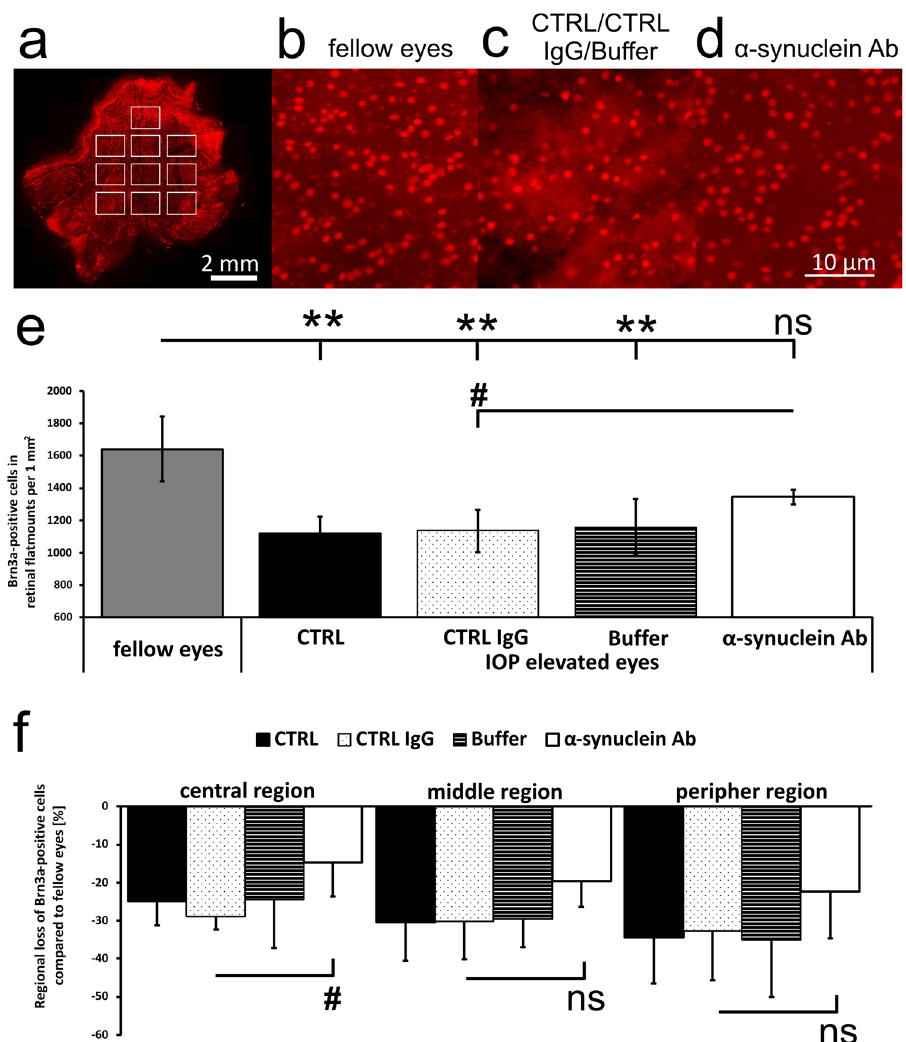
Figure 4. Survival of retinal ganglion cells in the retina after IOP elevation. Neurodegeneration was analyzed using Brn3a-immunostaining as a marker for retinal ganglion cells (RGC) on a quarter of retinal flatmounts. 10 images were taken for analysis and divided into central, middle and peripher position depending on the optic nerve head (ONH). ( a ) A representative stitched image of a quarter of retinal flatmount. Brn3a-staining highlights RGCs in the retina. ( b–d ) Representative high magnification images of Brn3a-positive cells with different densities from healthy (fellow eyes, b ) to severely damaged (CTRL/CTRL IgG/Buffer group, c ). IOP elevated eyes of α -synuclein Ab group showed slightly higher numbers of Brn3a-positive cells ( α -synuclein Ab, d ). ( e ) A significant loss of Brn3a-positive cells compared with fellow eyes was observed for CTRL, CTRL IgG and Buffer IOP elevated eyes, but not for α -synuclein Ab IOP elevated eyes. A significantly higher number of Brn3a-positive cells survived in α -synuclein Ab group compared with CTRL IgG group (student’s independent t-test by groups). ( f ) The regional loss in dependency to the optic nerve head was analyzed. Peripher region showed highest loss of Brn3a-positive cells, while the loss decreased gradually towards the optic nerve head. Especially in the central region, α -synuclein Ab showed a significant difference to CTRL IgG group. ** Represents p < 0.01 compared with fellow eyes. # Represents p < 0.05 compared with IOP elevated eyes of α -synuclein Ab group. ns = not significant. Scale bars as